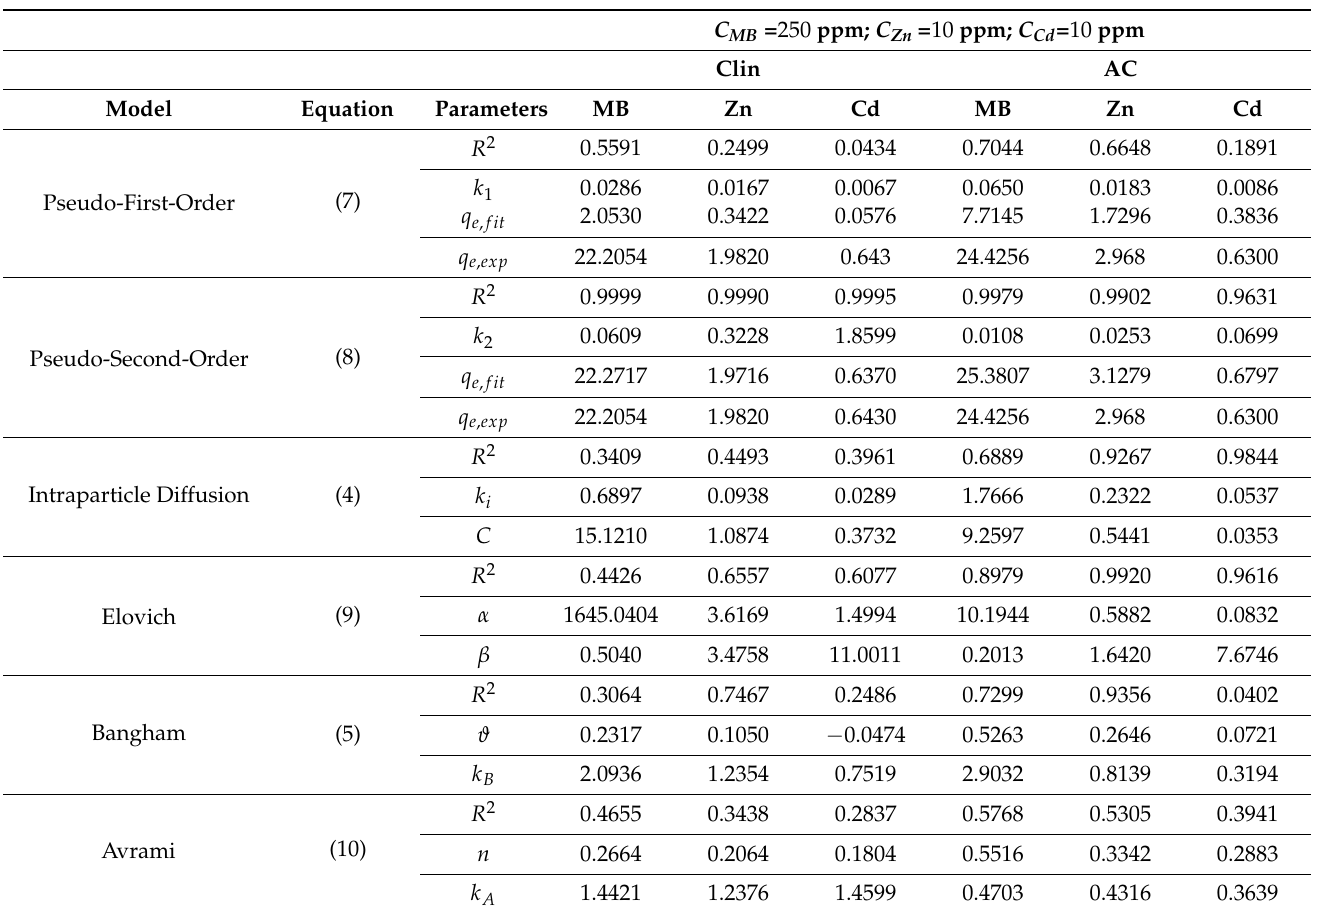
Table 5. Kinetic parameters of the system with 250 ppm MB, 10 ppm Zn 2+ , and 10 ppm Cd 2+ , using Clin and AC as